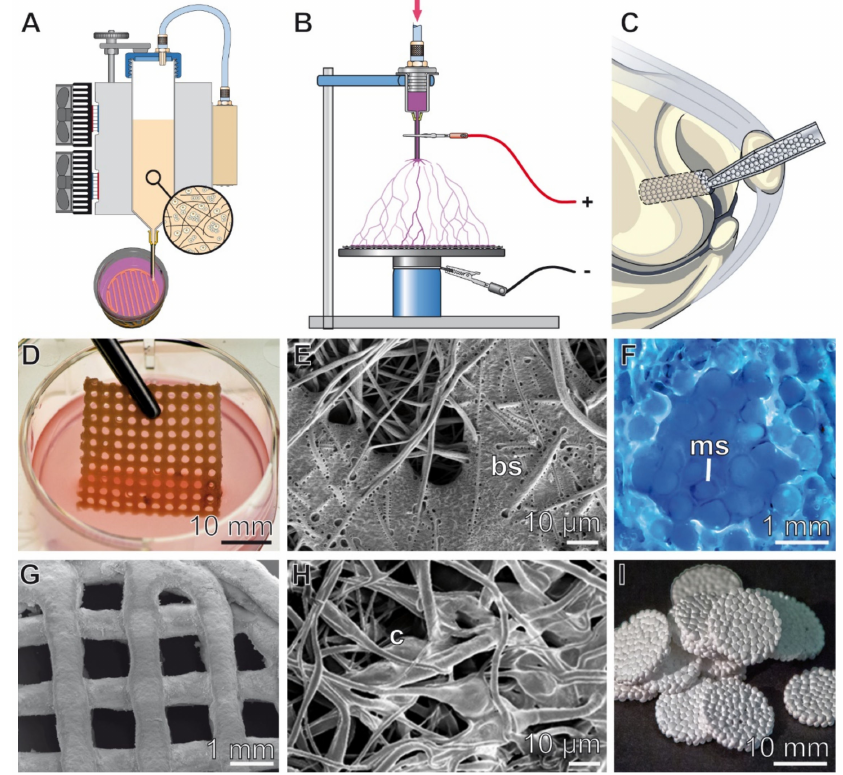
Figure 5. Different routes of administration of biosilica and polyP for tissue regeneration/repair. Both biosilica, either alone or together with silicatein, and polyP, as soluble polyP or polyP nanoparticles, can be applied by using ( A ) 3D printing techniques, ( B ) electrospinning, or ( C ) in a microparticular form, after encapsulation in poly( D , L -lactide- co -glycolide (PLGA). ( D – F ) Biosilica. ( D ) 3D printed grid of a biosilica-supplemented and SaOS-2 cells containing hydrogel. ( E ) Patches of biosilica (bs) deposits formed by silicatein on the surface of a TEOS-containing electrospun PCL nanofiber mat; SEM. Adapted with permission from ref. [113]. Copyright 2014, John Wiley and Sons. ( F ) Healing of a bone defect after implantation of PLGA-based microspheres, containing silica/silicatein. A tissue section from patella of rabbit in vivo labeled with oxytetracycline [115] is shown, allowing visualization of new bone formation; ms, microsphere. ( G – I ) PolyP. ( G ) 3D bio-printed disc prepared with a polyP-supplemented bio-ink solution, based on N , O -carboxymethyl chitosan; environmental scanning electron microscopy (ESEM). Adapted with permission from ref. [112]. Copyright 2022, IOP Publishing. ( H ) Electrospun fibrous mat fabricated with poly(lactic acid) (PLA) and amorphous Ca-polyP nanoparticles. After incubation with mouse calvaria MC3T3-E1 cells, the formation of cell (c) layers on the mats is visible. Adapted with permission from ref. [114]. Copyright 2015, Elsevier. ( I ) Discs prepared from amorphous polyP encapsulated into PLGA microspheres. Adapted with permission from ref. [116]. Copyright 2016, John Wiley and